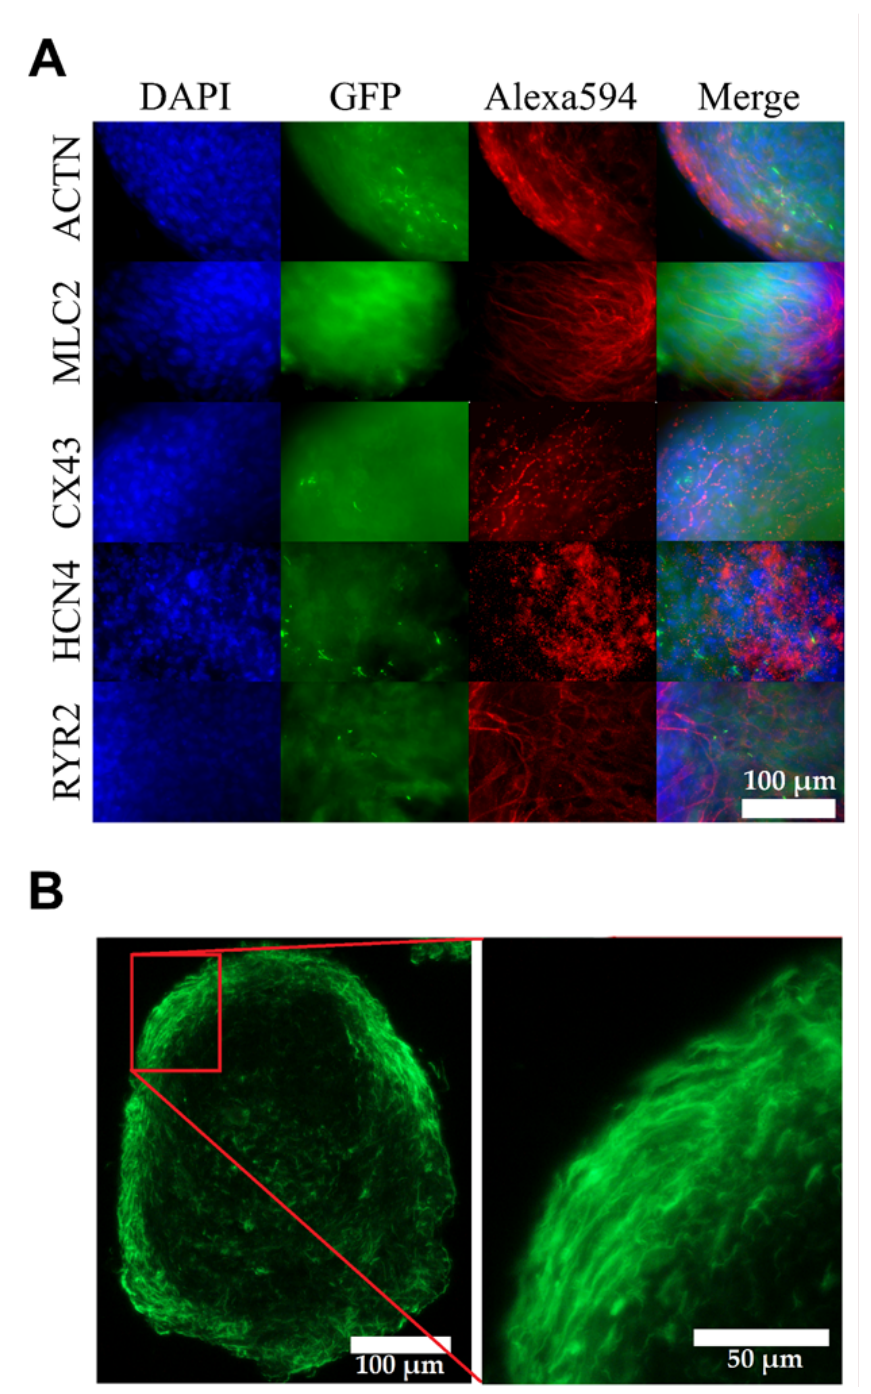
Figure 3. hPSC-CMC express the most important cardiac proteins after 100 days of differentiation and show discrete cell alignment. ( A ) Immunohistochemical staining of whole hPSC-CMC. The proteins ACTN, MLC2; CX43, HCN4, and RYR2 (vertical) are shown in red. Cell nuclei were counterstained with DAPI (blue), GFP (green) was expressed intrinsically under the control of the cTNT promoter; the outer left column shows a merge of these channels. ( B ) Unstained cross-section shows the green cTNT-GFP